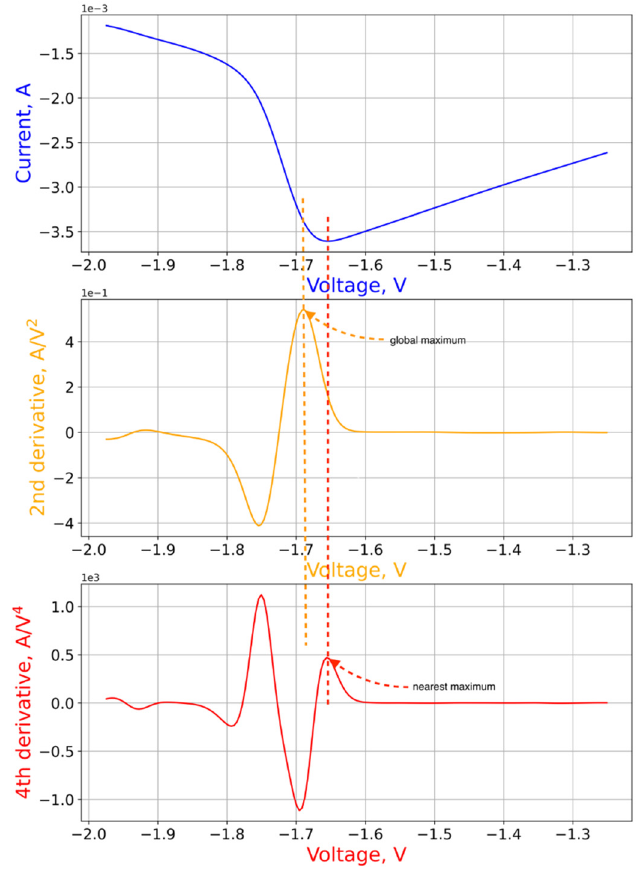
Figure 4. Application of the second derivative criterion to find the negative threshold voltage. The second step of the algorithm is the partition of the VAC into low-resistance and high-resistance branches with subsequent interpolation by polynomials or kernel smoothing. The endpoints of each branch are extreme right and left points of the VAC, and the choice in favor of one or another method of approximation is determined by the number of points in the experimental